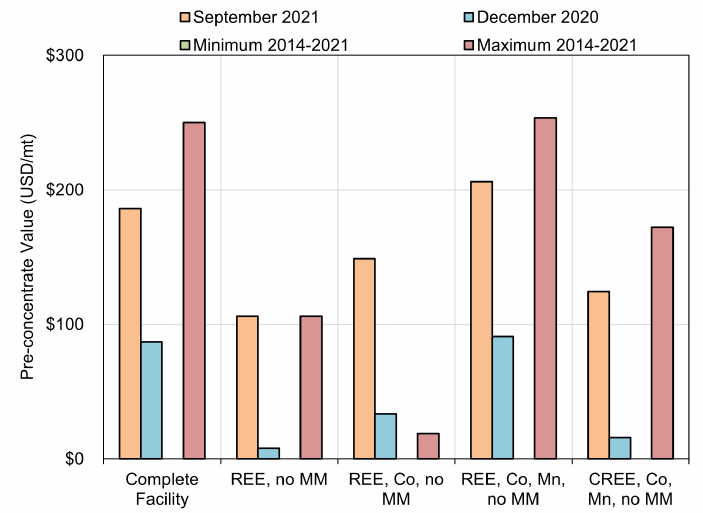
Figure 5. Internal rate of return results for various operational configurations and pricing scenarios.